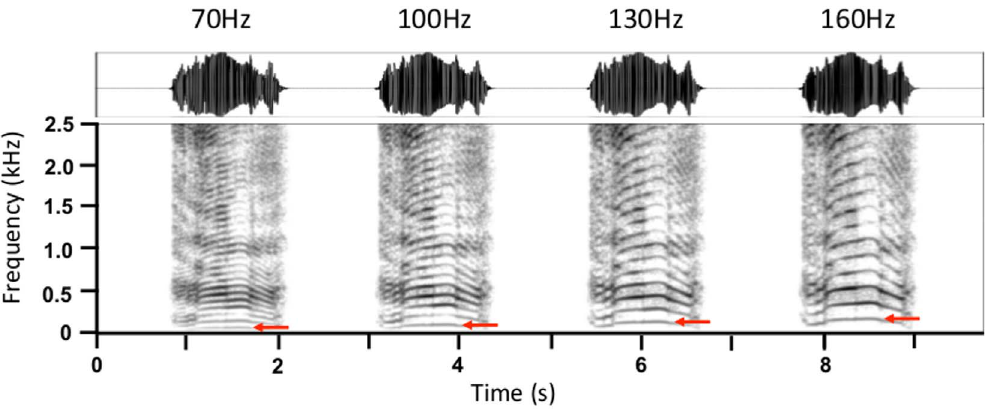
Figure 1. Spectrograms of resynthesized roars from one of the male exemplars showing the four F0 variants. F0 (indicated by the red arrow) was re-scaled to median values of 70 Hz, 100 Hz, 130 Hz and 160 Hz. All other acoustic parameters (duration, intensity contour, amplitude, formant frequencies etc.) remained unchanged.